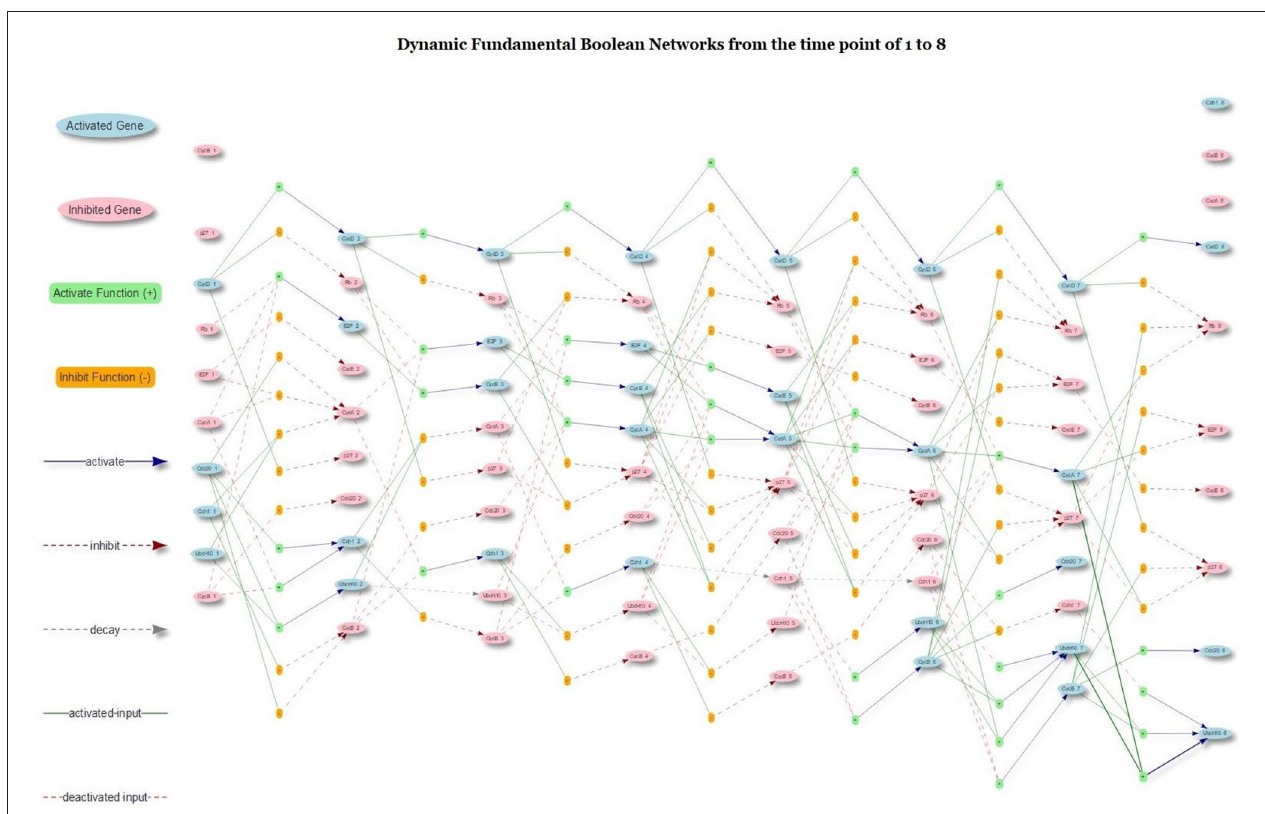
FIGURE 11 | The dynamic trajectory of attractor 2. The underscore mark “_” indicates the time step that the gene was located.